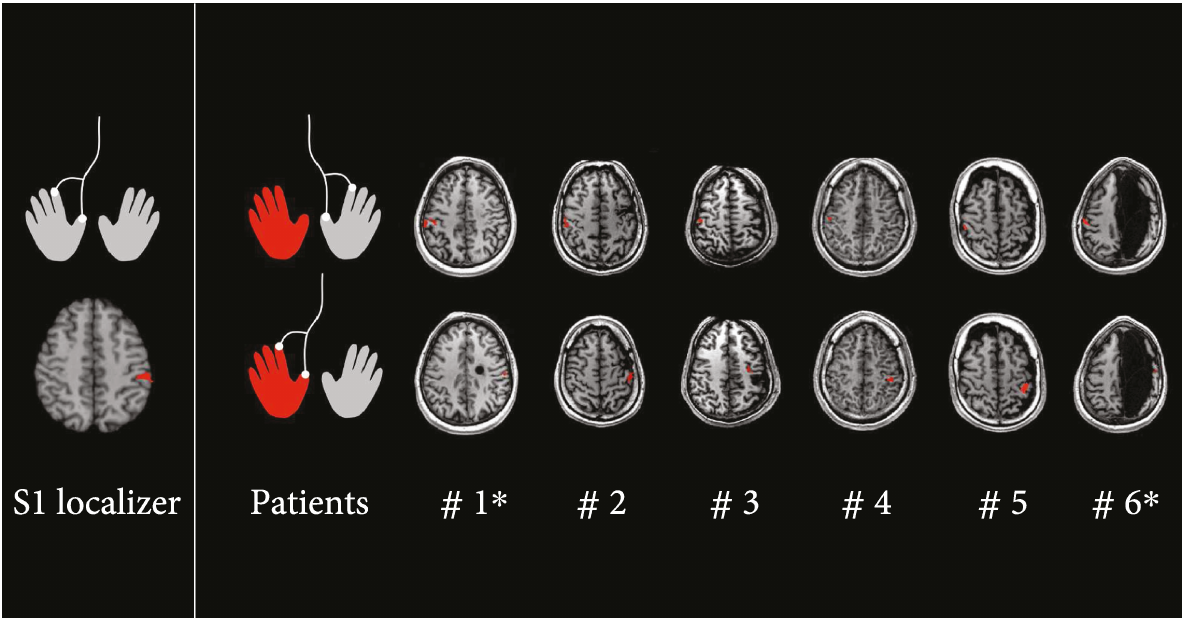
Figure 1: S1 activation rendered on T1 axial images for control group analysis (S1 localizer) and single-subject analysis (patients). The gentle tactile stimulation in the dominant hand elicits a contralateral S1 activation in the group analysis (S1 localizer). Single-subject analyses reveal that the gentle tactile stimulation elicits a unilateral S1 contralateral activation pattern for both nondominant (red) and dominant (grey) hands (patients). ∗ Right brain lesion.